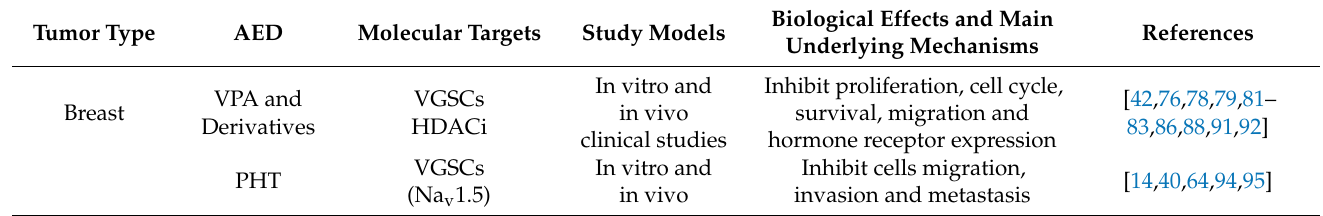
Table 1. Anticancer activity of several AEDs in different tumor types. Molecular targets, biological effects and main underlying mechanisms are